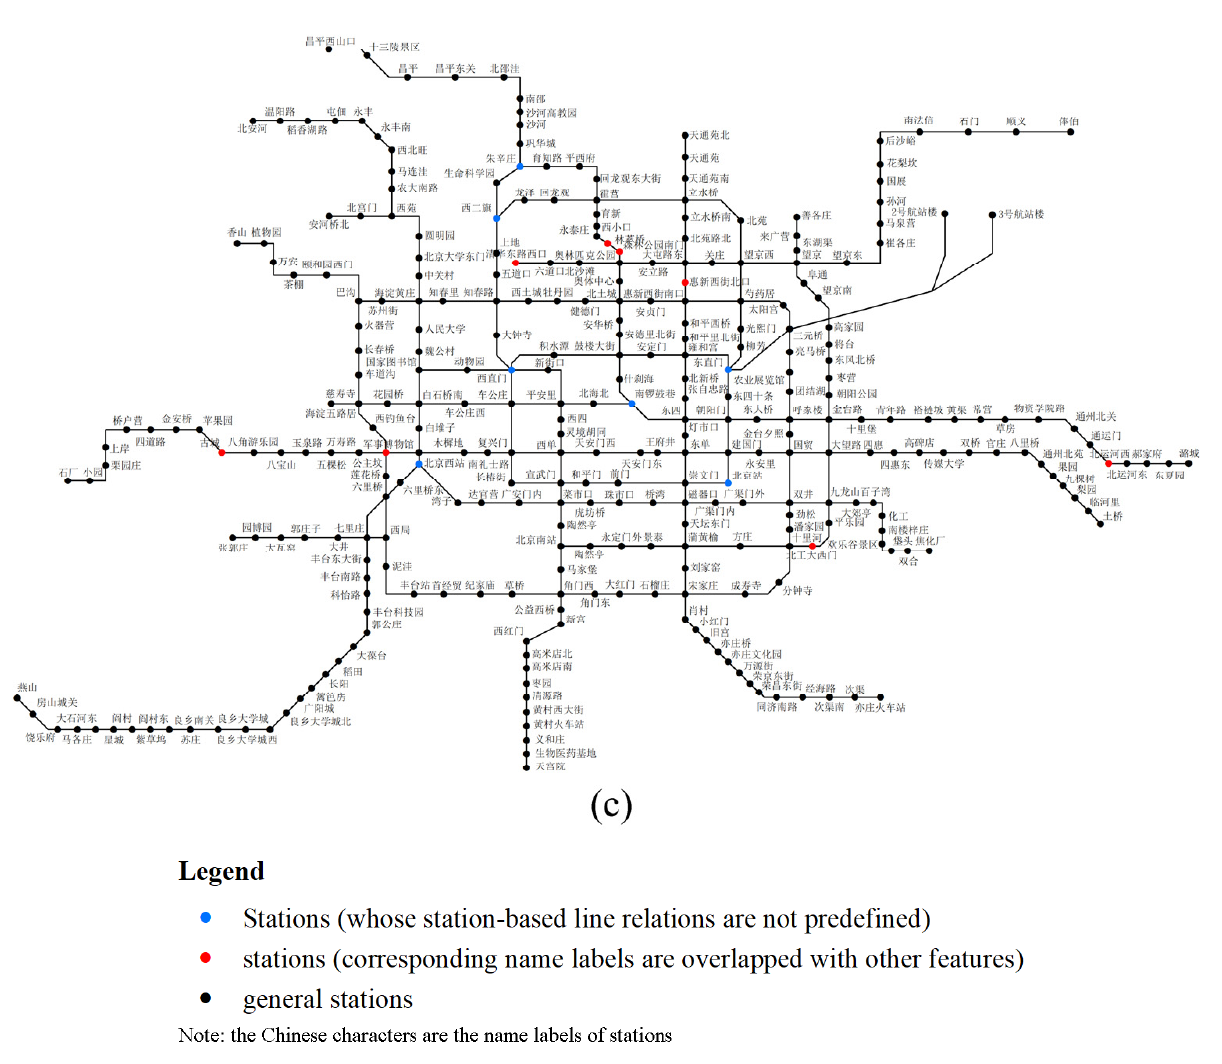
Figure 11. Name labels of Beijing metro networks placed by: ( a ) maplex; ( b ) descriptive-statistics- based method; and ( c ) ANNs.